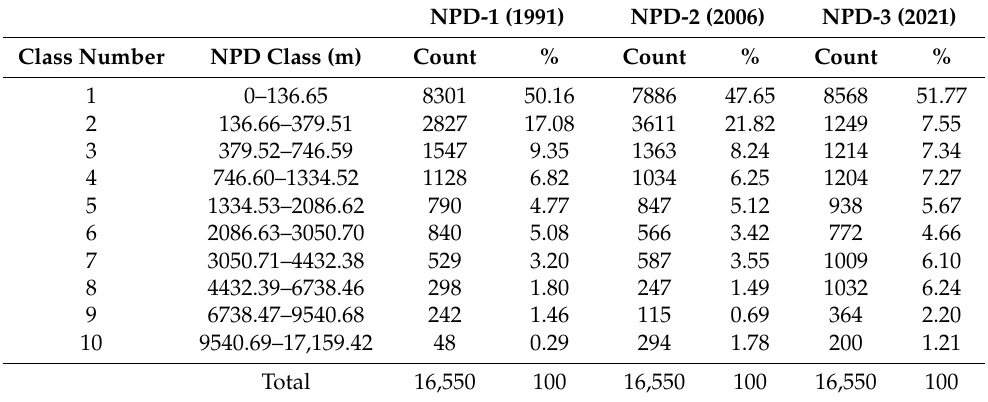
Table 3. Count (number) and percentage of baseline GRPs by near point distance (NPD) classes to shorelines.